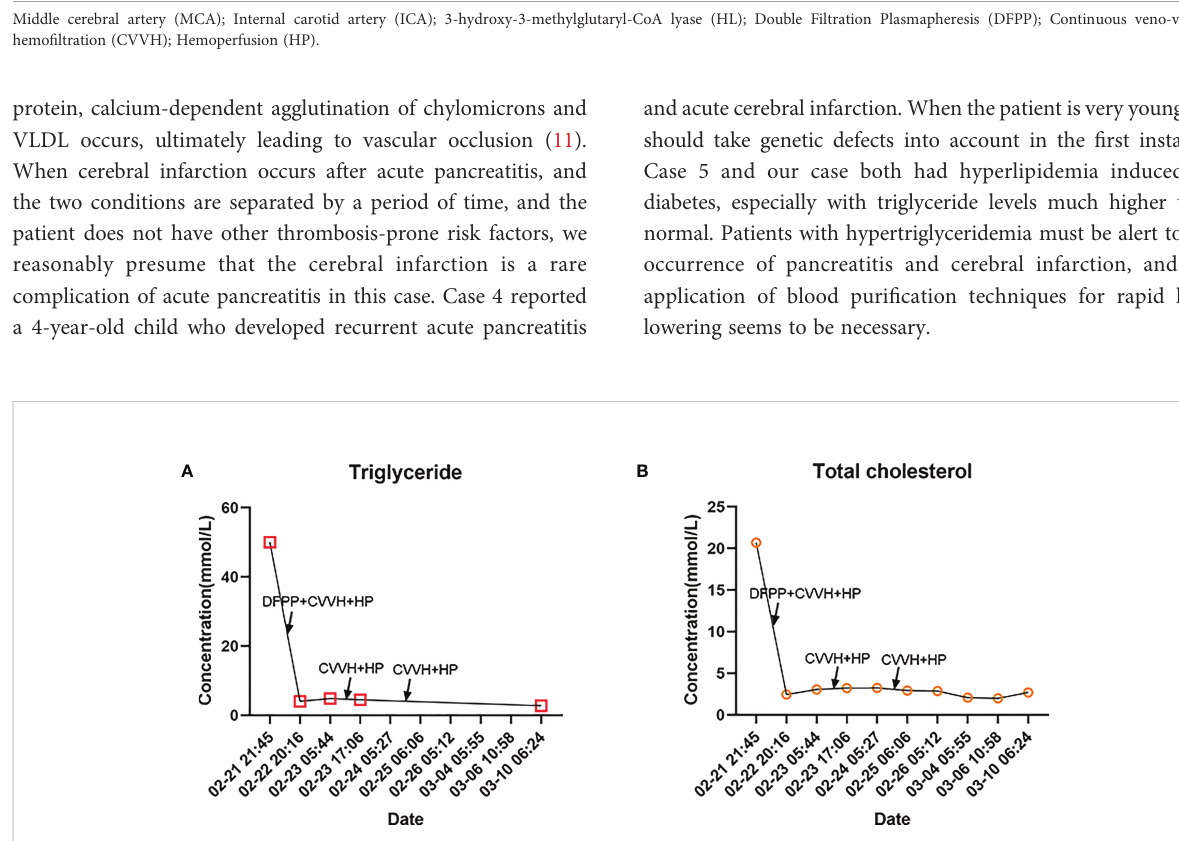
FIGURE 2 Major lipid trends in our patient. (A) Trends in triglyceride changes during hospitalization. Maximum lipid-lowering bene fi t was obtained in the fi rst combined blood puri fi cation therapy, with further reduction in triglyceride levels in the subsequent treatment. (B) Trends in total cholesterol changes during hospitalization. The trend was generally consistent with triglyceride levels, and total cholesterol levels returned to normal after the fi rst combined blood puri fi cation therapy. Abbreviations: Double Filtration Plasmapheresis (DFPP); Continuous veno-venous hemo fi ltration (CVVH); Hemoperfusion